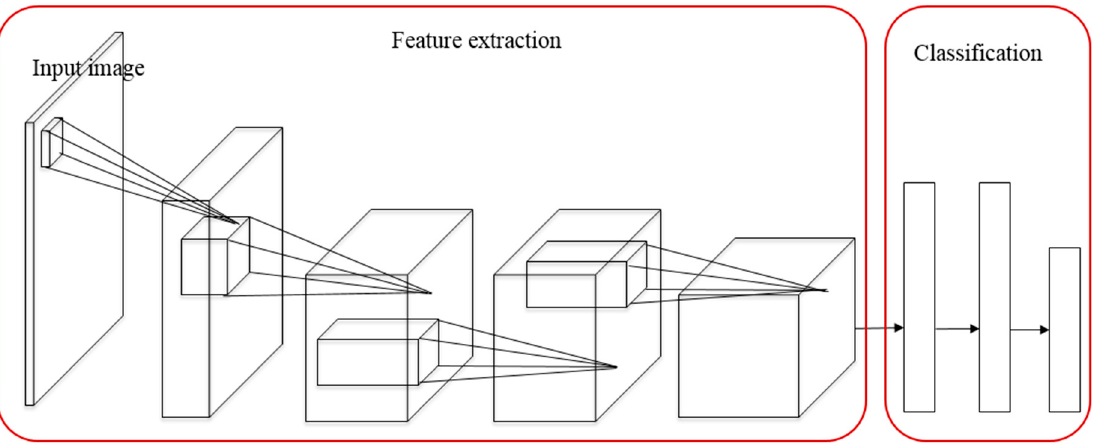
Figure 1. The structure of a convolutional neural network ( CNN).